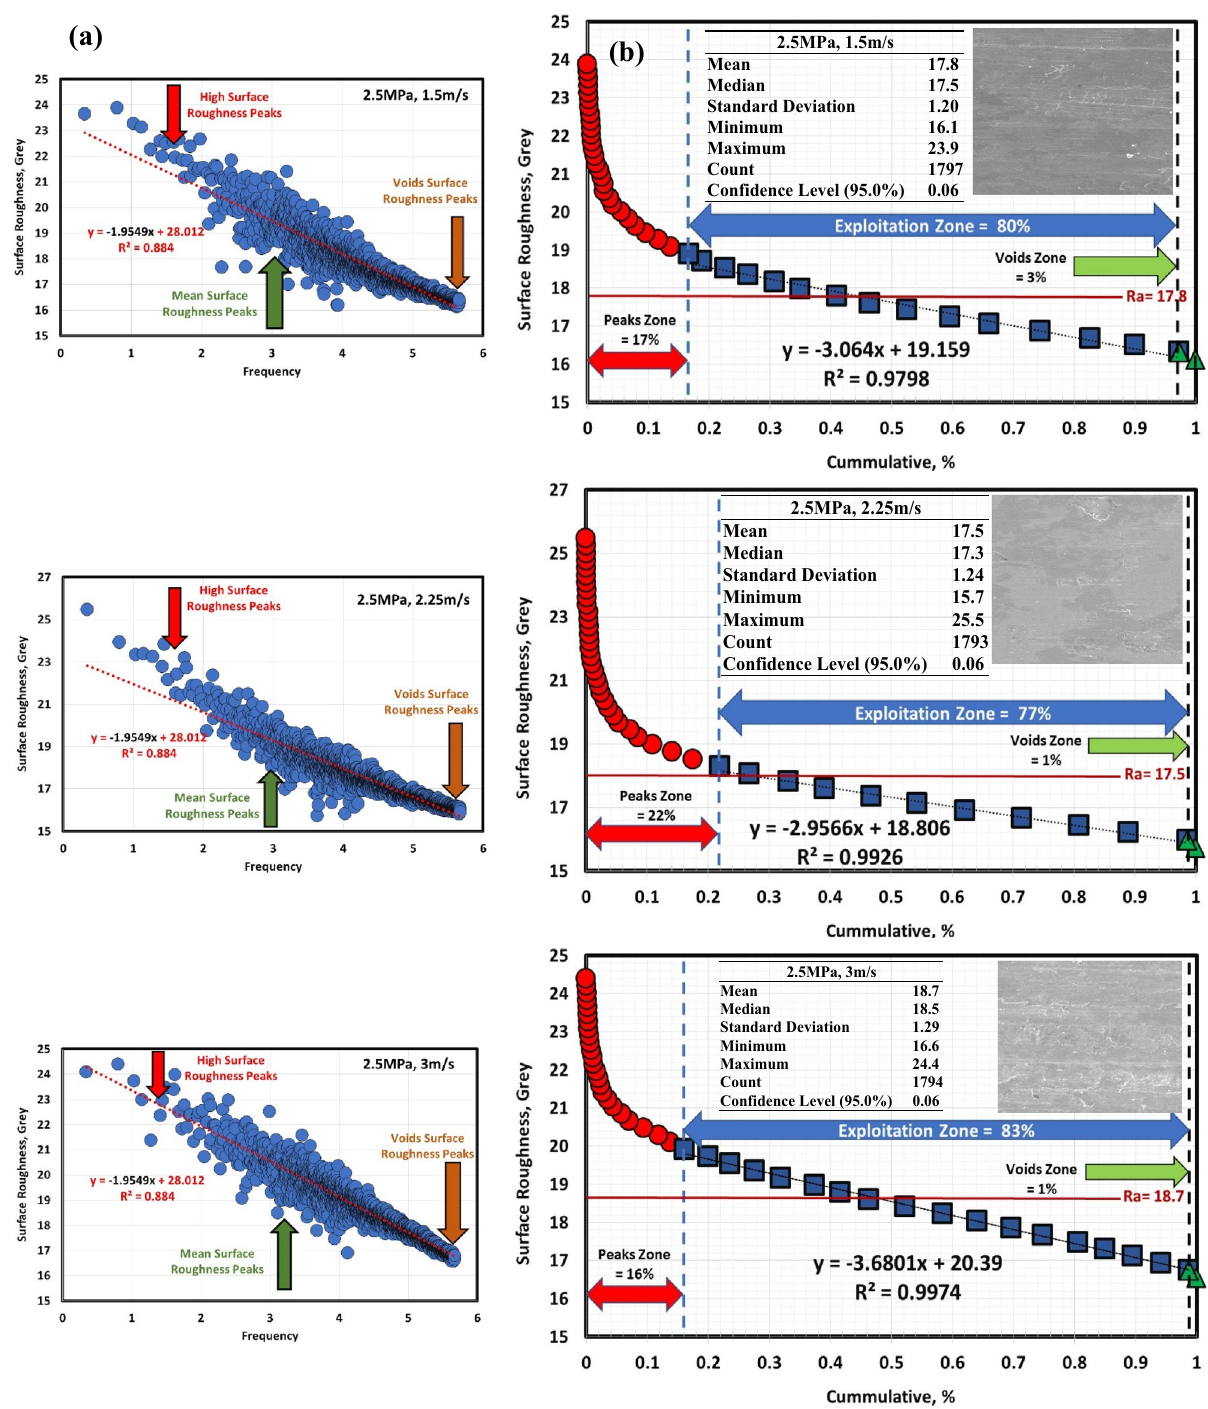
Figure 8. ( a ) Surface texture and ( b ) Abbott Firestone curves at 2.5 MPa and different velocities of